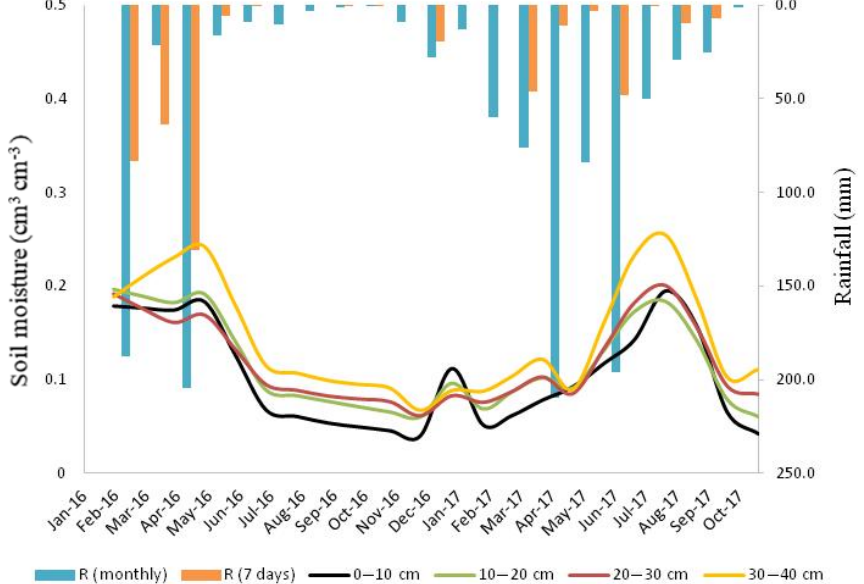
Figure 5. Mean soil moisture for different layers along soil profile, measured using the Diviner Probe, for sites with the same vegetation cover